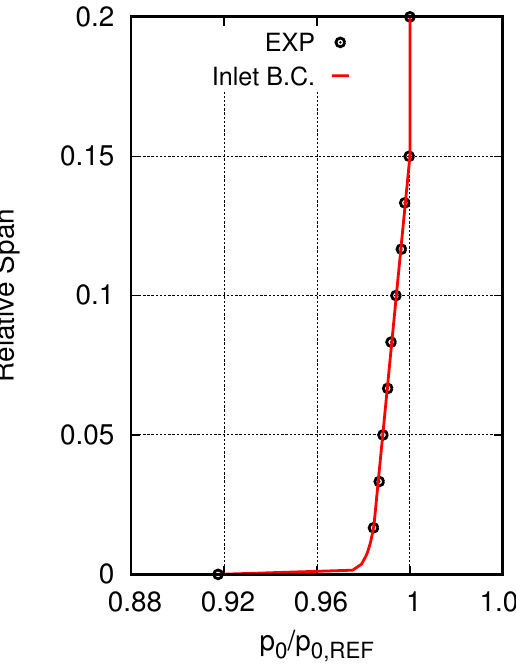
Figure 2. Inlet boundary layer total pressure